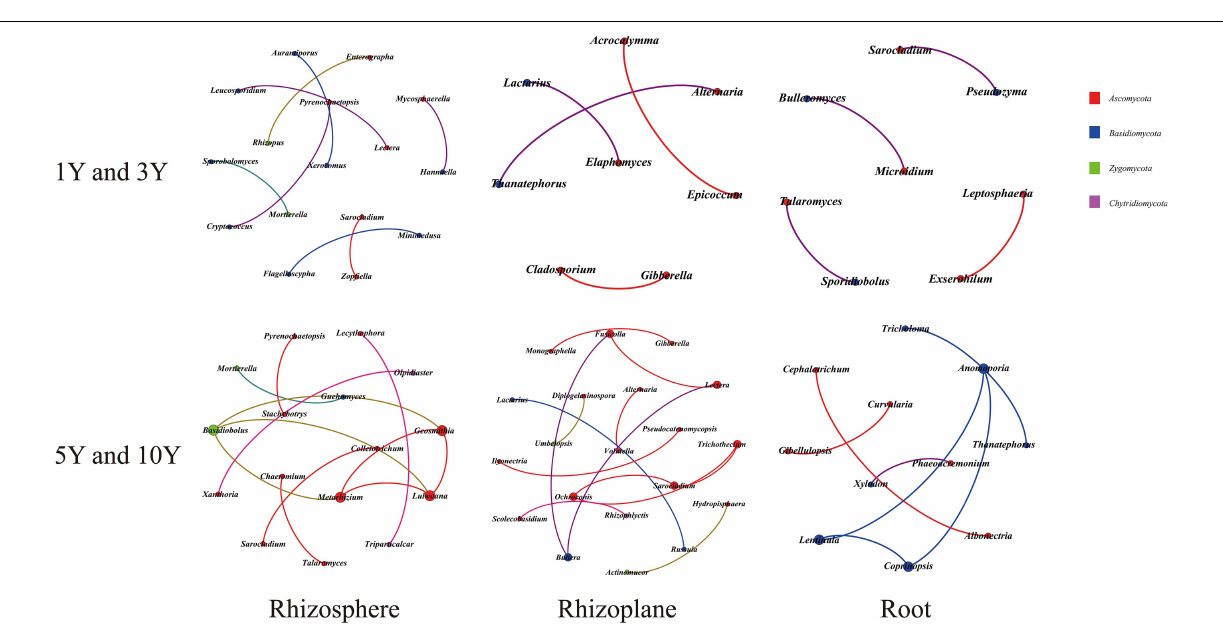
FIGURE 4 | The co-occurrence network of fungal genera based on correlation analysis for different samples in three root-associated compartments. A connection stands for a strong (Spearman’s r > 0.6) and significant ( p < 0.01) correlation. The size of each node is proportional to the degree. Nodes colored by